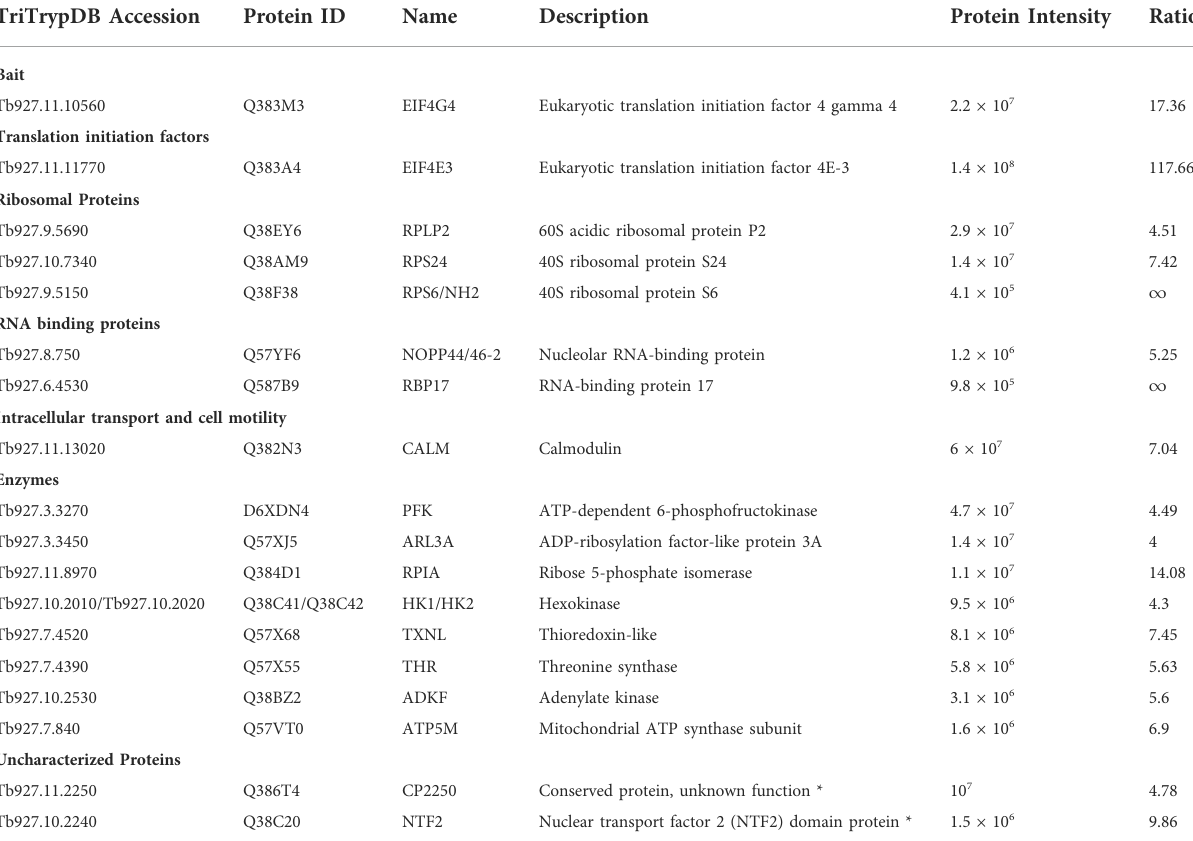
TABLE 2 Most enriched proteins co-precipitated with the eYFP-tagged EIF4G4 in Trypanosoma brucei procyclic